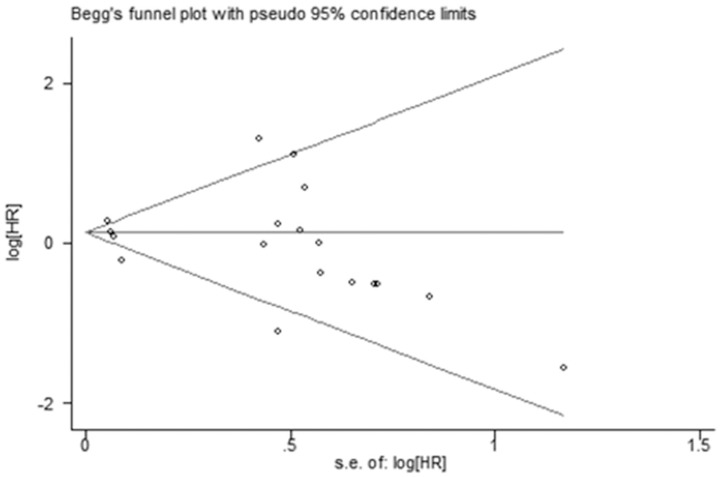
Egger’s plot to detect publication bias on overall estimate.